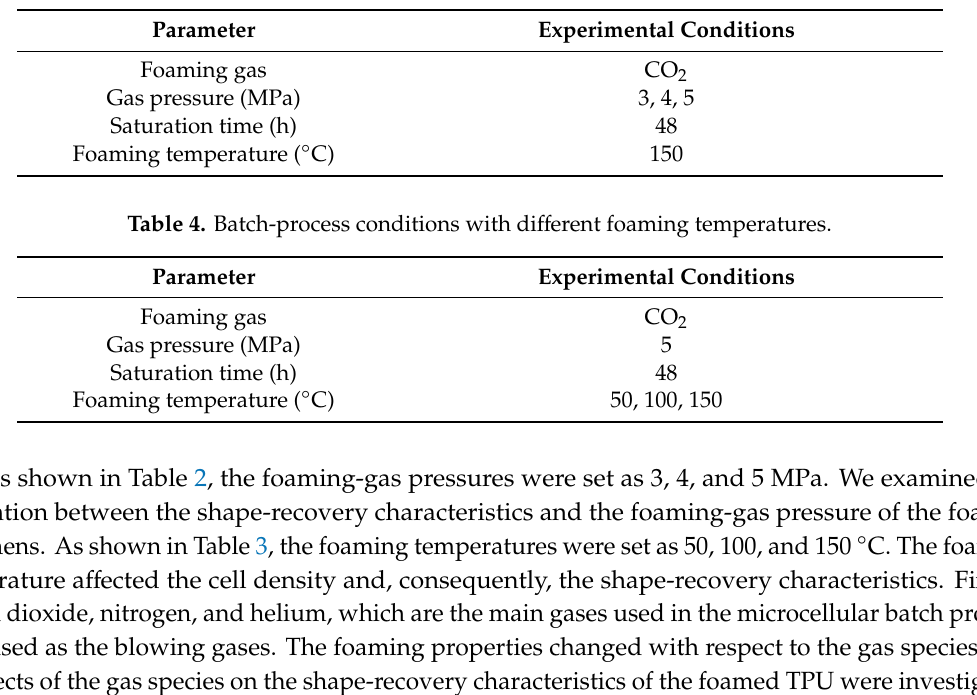
Table 3. Batch-process conditions with di ff erent gas pressure.